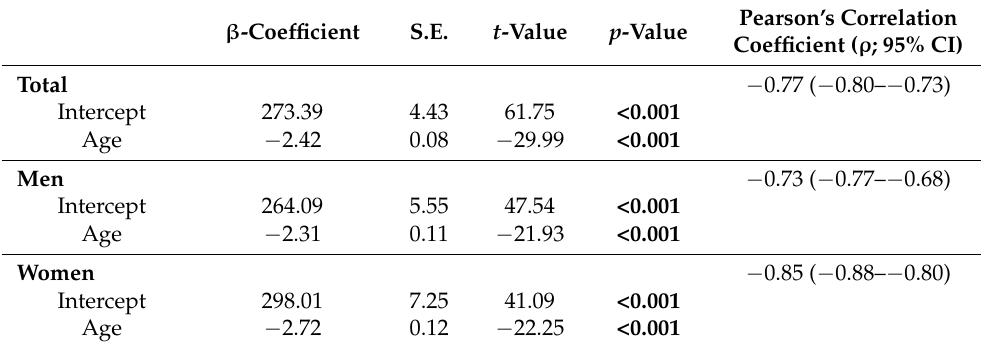
Table A1. Linear regression analyses and correlation coefficients of bone mineral density as dependent variable in the total cohort and per sex group.